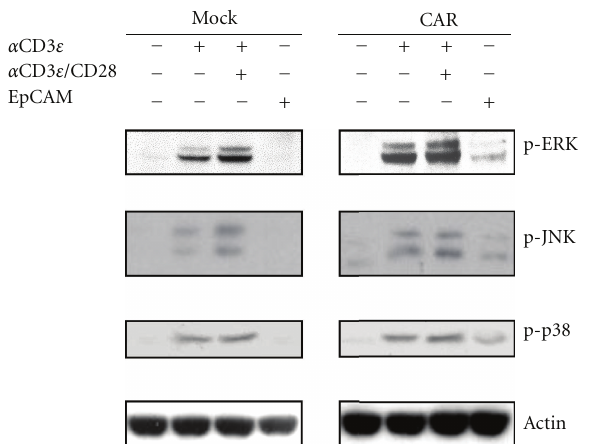
Figure 5: IL-2 secretion from CAR-expressing Jurkat cells. The concentration of IL-2 in the cell supernatant was measured 24h after stimulation with an anti-CD3 antibody, anti-CD3 plus anti- CD28 antibodies, or